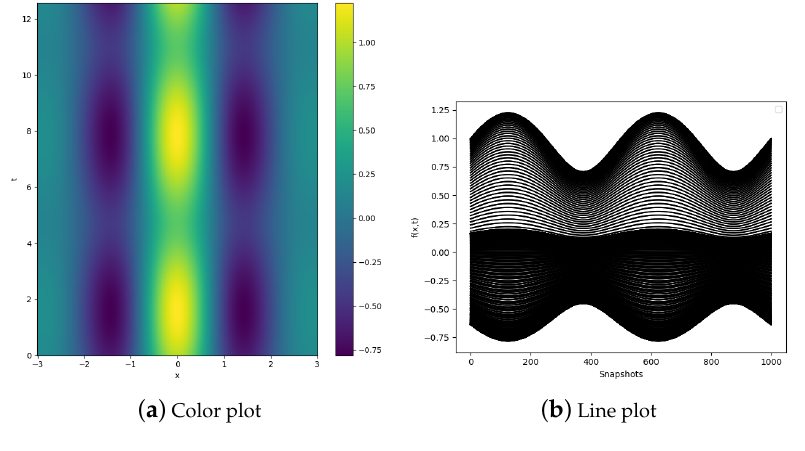
Figure 2. Function f ( x , t ) .